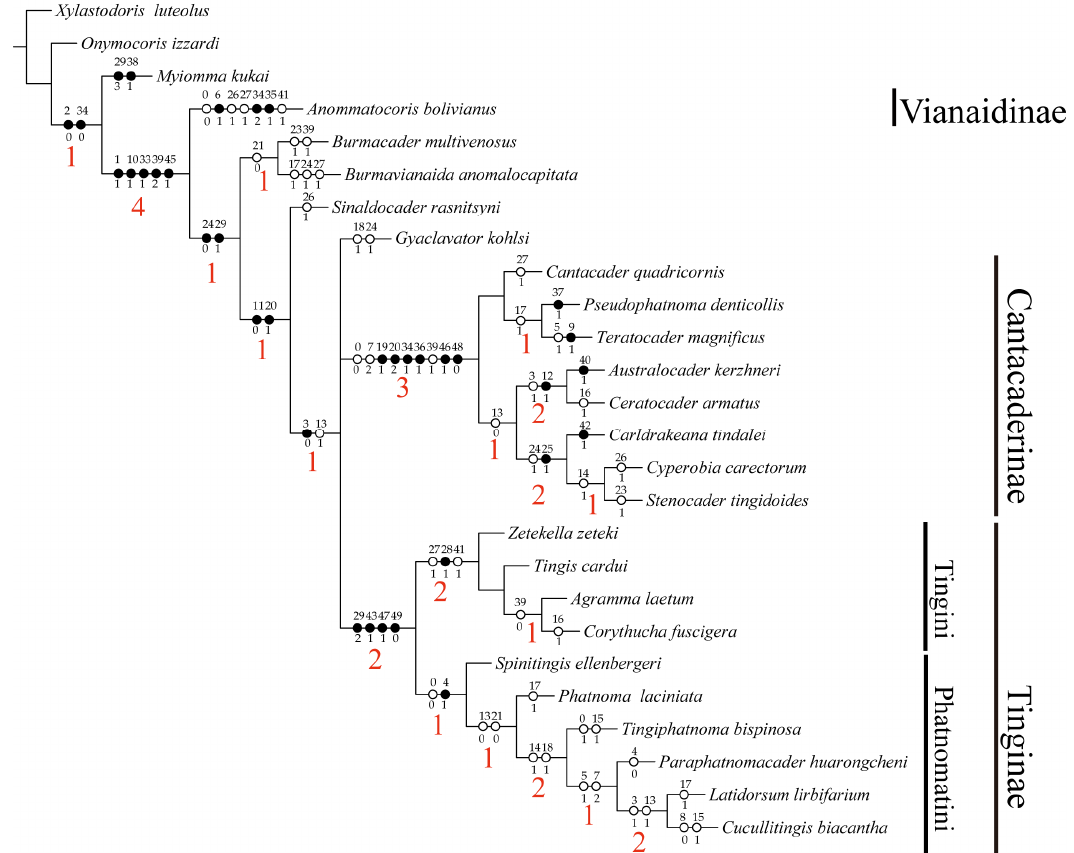
Figure 3. The strict consensus tree for the analysed Tingidae: tree length = 106 steps; consistency index = 0.59; retention index = 0.80. • , non-homoplastic changes; , homoplastic changes. The larger red (bold) numbers below the branches are Bremer support values.